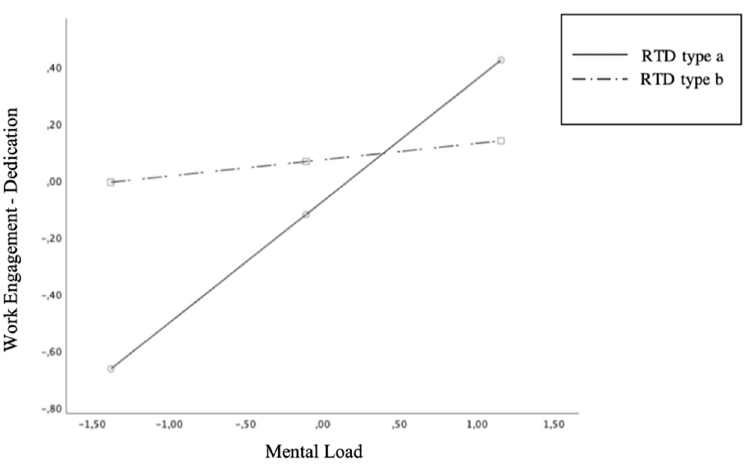
Figure 3. Interaction effect between Mental Load and RTD type (a/b) on Dedication.